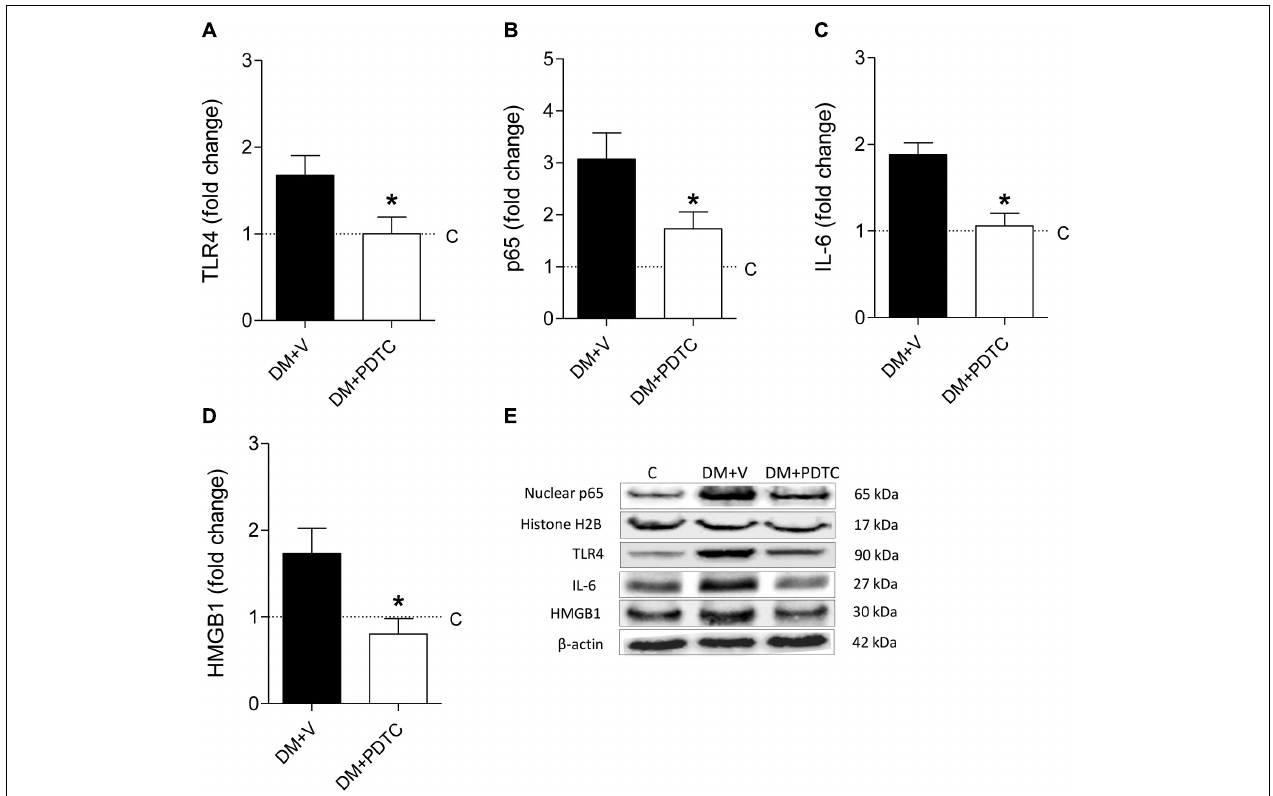
FIGURE 5 | DM rats treated with the NF- κ B inhibitor pyrrolidine dithiocarbamate (PDTC) (DM+PDTC group, n = 11) or vehicle (DM+V, n = 16), were followed for 12 months. At the end of this period, the renal cortical content of (A) Toll-like receptor 4 (TLR4), (B) nuclear fraction of phosphorylated p65, (C) interleukin 6 (IL-6), and (D) high mobility group box protein-1 (HMGB1) were quantified using (E) Western blot analysis. Values obtained from groups DM+V and DM+PDTC were factored by age-matched controls rats (C, horizontal dotted lines). Results expressed as means ± SE. * p < 0.05 vs.